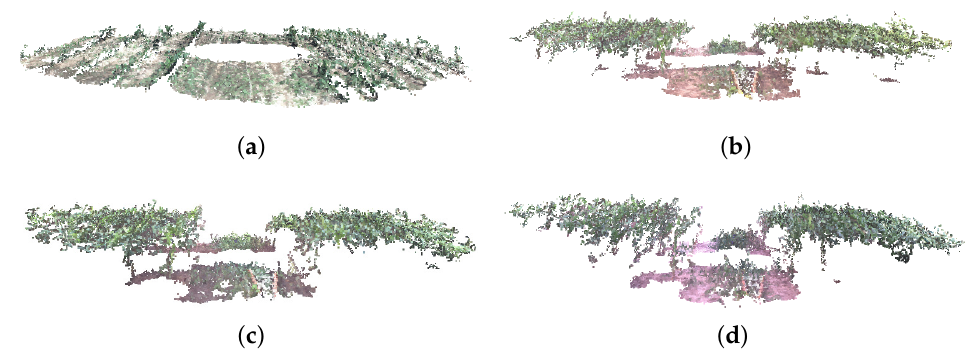
Figure 16. 3D Reconstruction of entire field (side view) using stereo RGB images collected by the